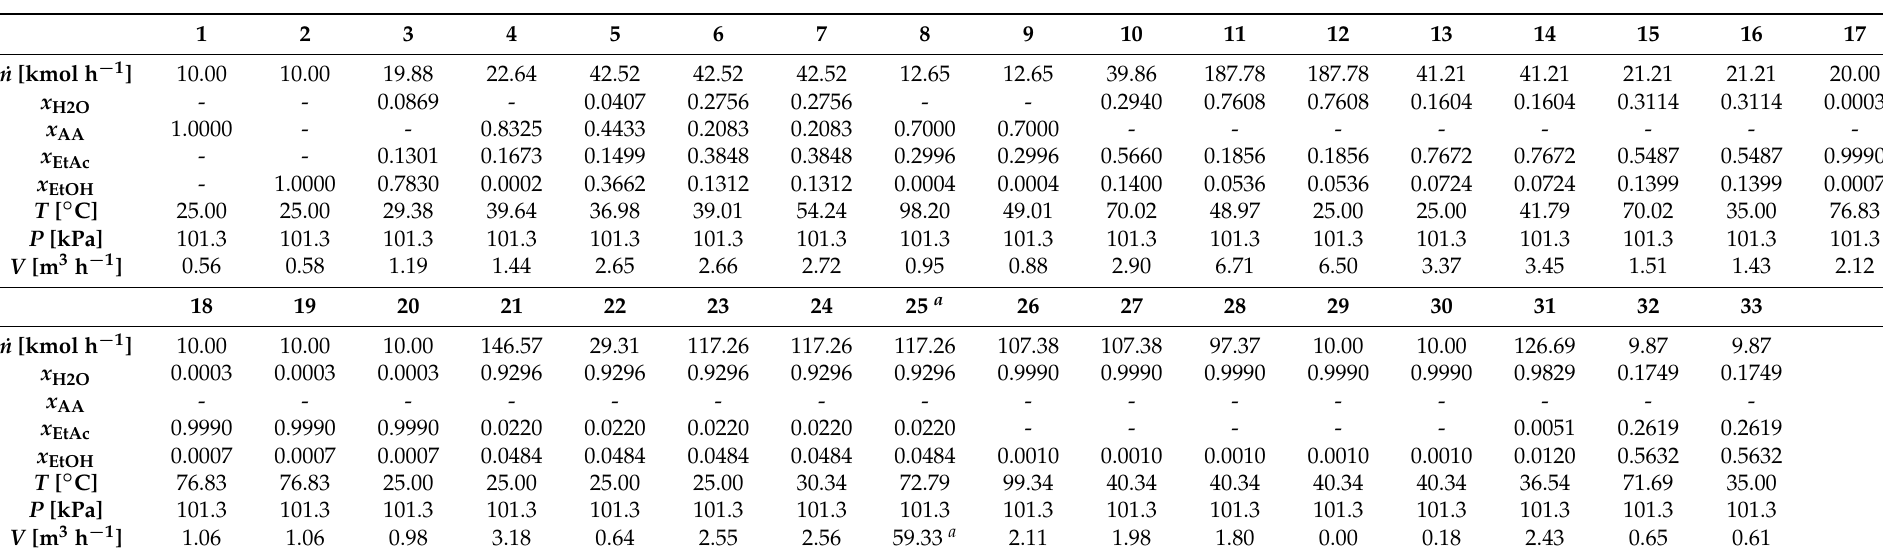
Table A1. Material balance of designed conventional process set-up (Figure 2) adapted from our previous work [5]; Material balance of designed conventional process set-up with an MVRHP (Figure